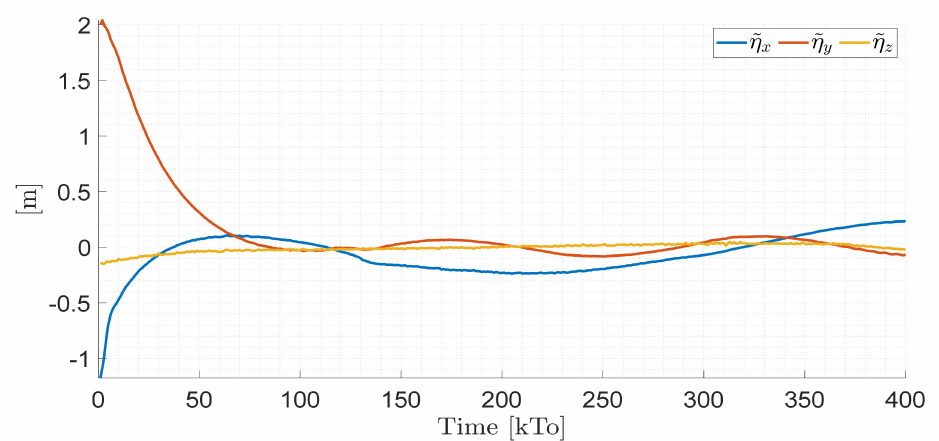
Figure 25. Time evolution of the control errors ˜ η ( kT 0 ) = ( ˜ η x , ˜ η y , ˜ η z ).